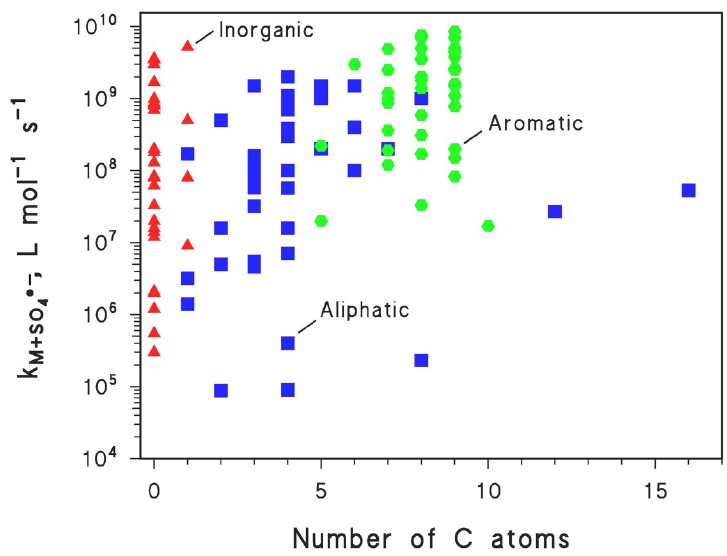
k ) of inorganic (  ), aliphatic (  ) and aro- Figure 2. Second-order reaction rate constants ( −• + Figure 2. Second-order reaction rate constants ( k ) of inorganic ( (cid:78) ), aliphatic ( (cid:4) ) and aromatic M + SO •− 4 4 SOM matic ( ) compounds M with SO 4• − , as a function of the number of carbon atoms. Rate constant data were derived from the work in Figure 1. Second-order reaction rate constants ( k ) of organic compounds with SO 4• − (•, n = 119) and with • OH ( □ , n = 713), as a function of the number of carbon atoms (on average, compounds with